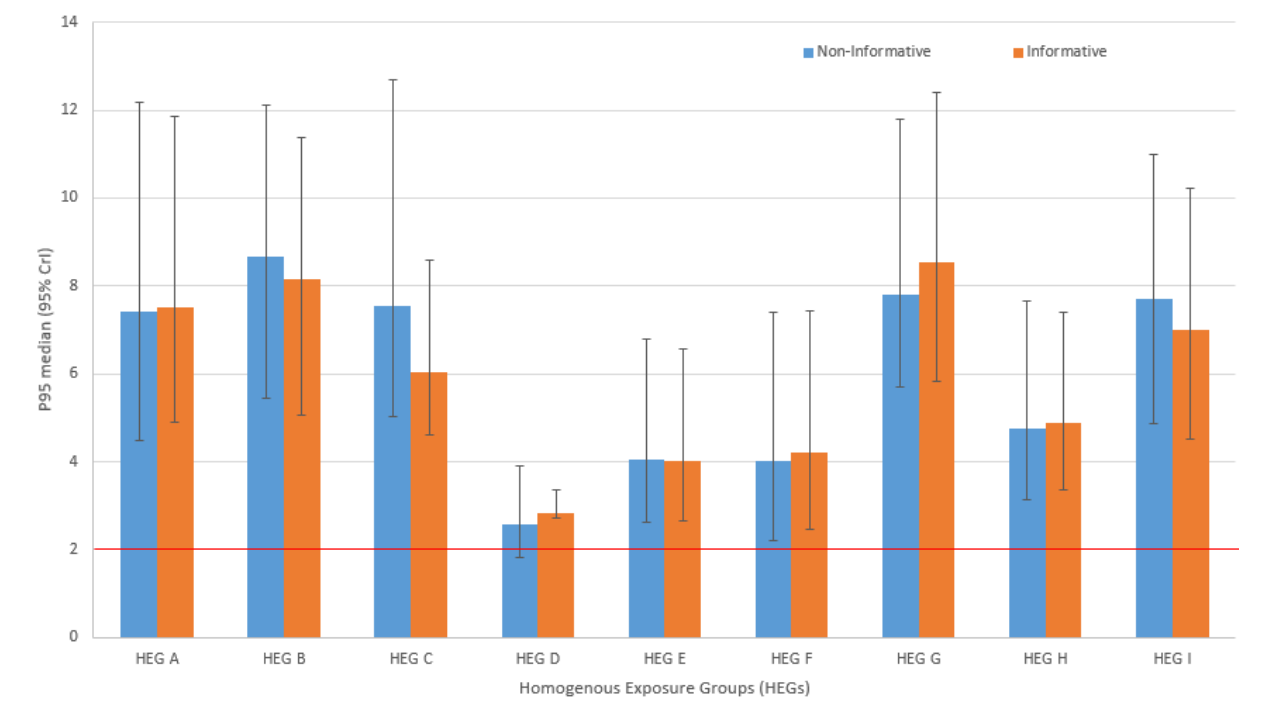
Figure 1. The comparison of the patterns of the posterior median (95% CrIs) of the P95 for non- informative and informative Bayesian framework across HEGs. The red horizontal is the SA OEL of 2 mg/m 3 . Table 4. The estimated exposure category probabilities of the non-informative and informative Bayesian frameworks for the posterior 95th